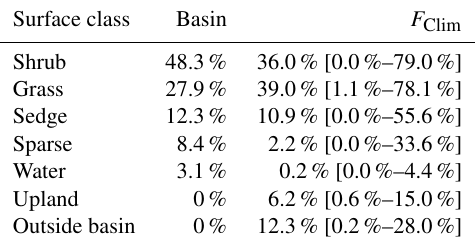
Table 2. The surface cover class fractions of the basin, along with the mean source area fractions of the footprint climatology ( F Clim ) and the range of source area fractions for individual half-hourly ob- servations shown in